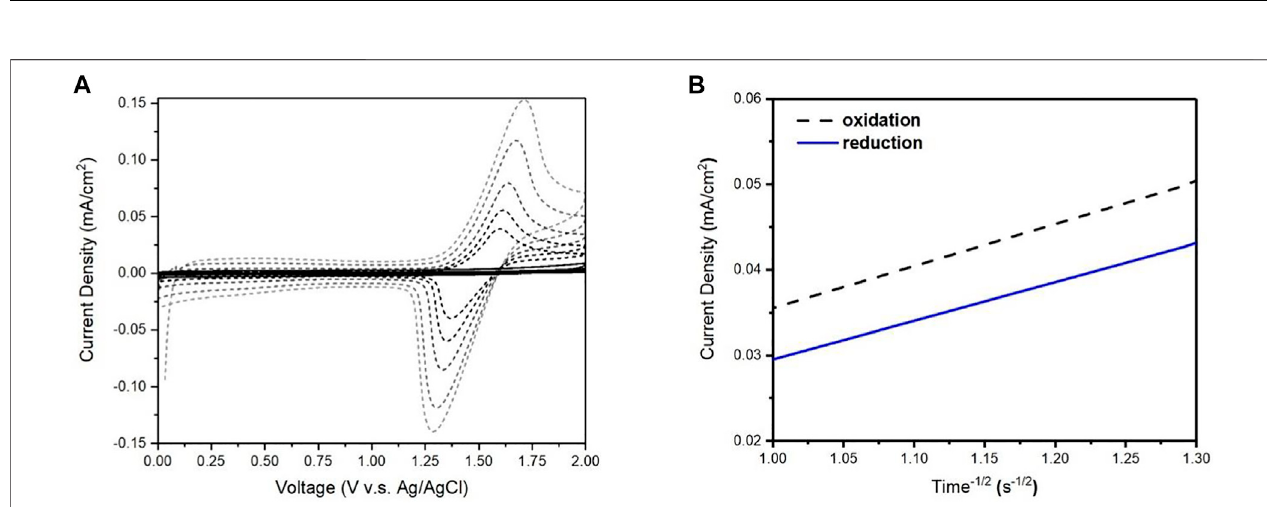
FIGURE2|(A) CyclicvoltammogramsofNU-1008(solid)andRu-bpy@NU-1008(dash)withvariousscanrates(25,50,100,200,and300 mV/s,withthelinecolor fadingtograyasthesweepincreases). (B) Cottrellplots(currentdensity vs .time − 1/2 plots)ofoxidationandreductiondirectionsofRu-bpy@NU-1008in0.1 MTBAPF 6 in